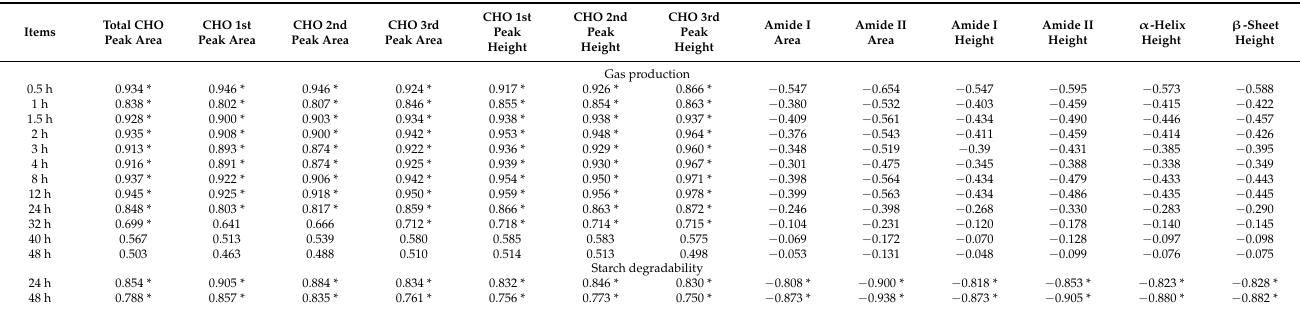
Table 4. Correlation between molecular structure and in vitro gas production and starch degradability of corn processed in different ways.